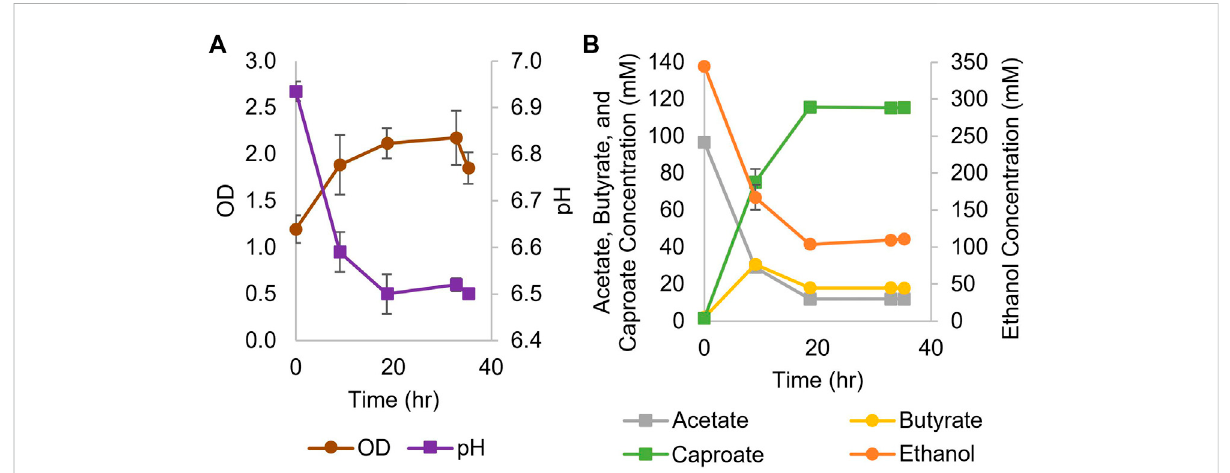
FIGURE 1 Growth and metabolite pro fi les of Ckl cultures for caproate production from ethanol and acetate. (A) : OD and pH of cultures in serum bottles ( n = 2 biological replicates). OD 600 can be converted to mgCDW/mL by multiplying the OD 600 by 0.43. (B) : Metabolite concentrations. Note the separate axis for ethanol